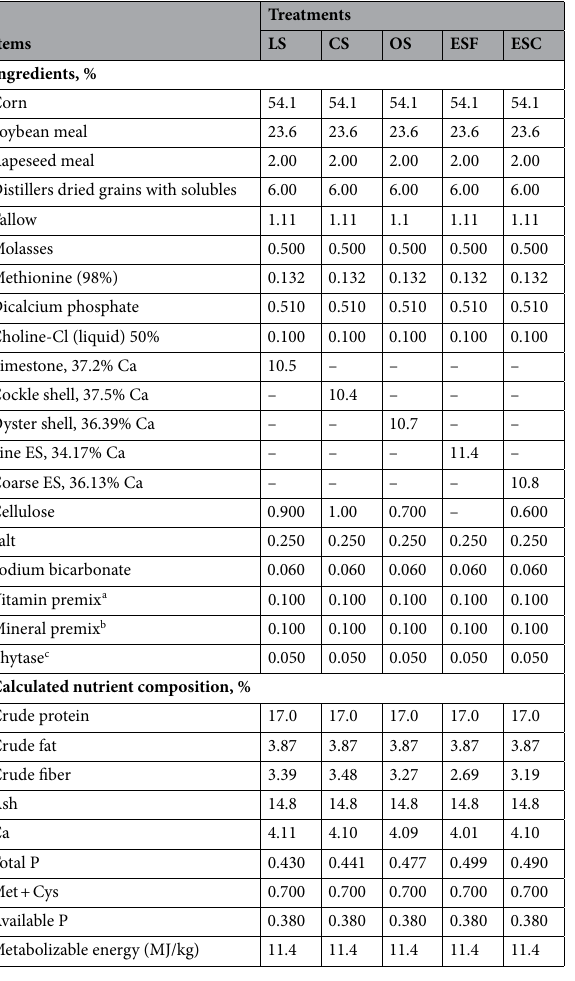
Table 5. Ingredients and nutrient composition of the experimental diets. LS limestone (< 2 and 2–4 mm mixed in 3:7); CS cockle shell (1–4 mm); OS oyster shell (3–16 mm); ESF eggshell fine particles (< 1 mm); ESC eggshell coarse particles (3–5 mm). Met methionine, Cys cysteine. a Vitamin premix supplied the following per kg of diet: vitamin A, 8000 IU; vitamin D3, 3300 IU; vitamin E, 20 g; vitamin K, 2.5 g; vitamin B1, 2.5 g; vitamin B2, 5.5 g; vitamin B3, 30 g; vitamin B5, 8 g; vitamin B6, 4 g; vitamin B7, 75 mg, vitamin B9, 0.9 g; vitamin B12, 23 mg. b Mineral premix supplied the following per kg of diet: Choline, 110 g; Manganese, 90 g; Zinc, 80 g; Iron, 40 g; Copper, 8 g; Iodine, 1.2 g; Selenium, 0.22 g. c 1,000,000 phytase units